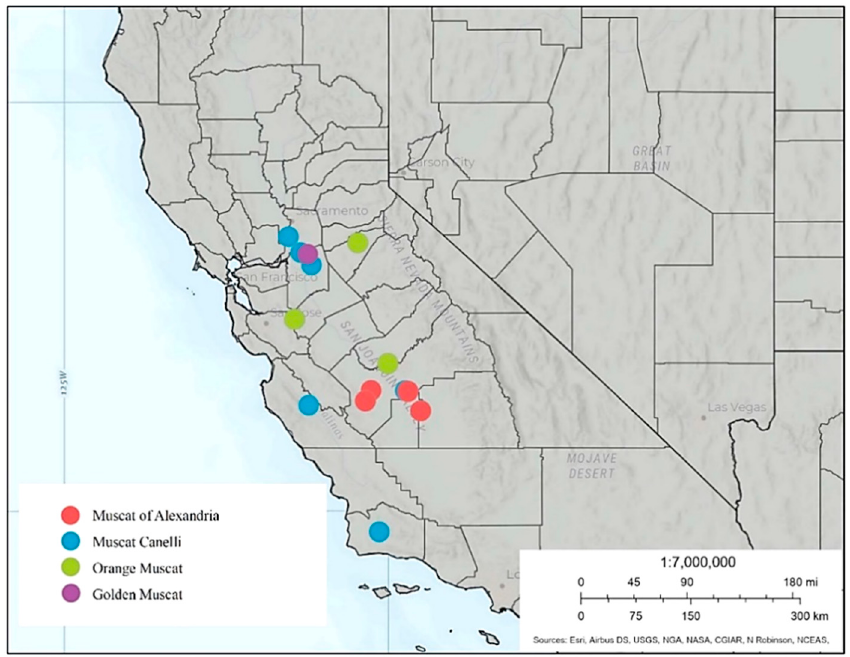
Figure 1. Vineyard locations for all Muscat varieties included in this study.